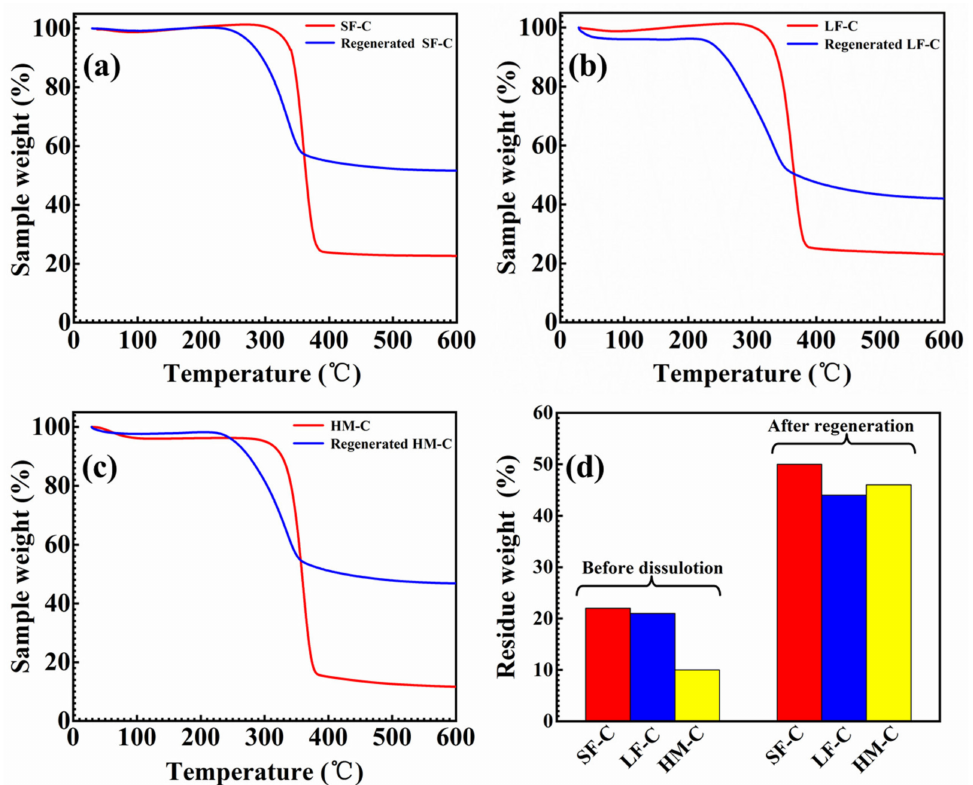
Figure 6. Thermal analysis of the cellulose and regenerated cellulose from its glycerin / NaOH aqueous